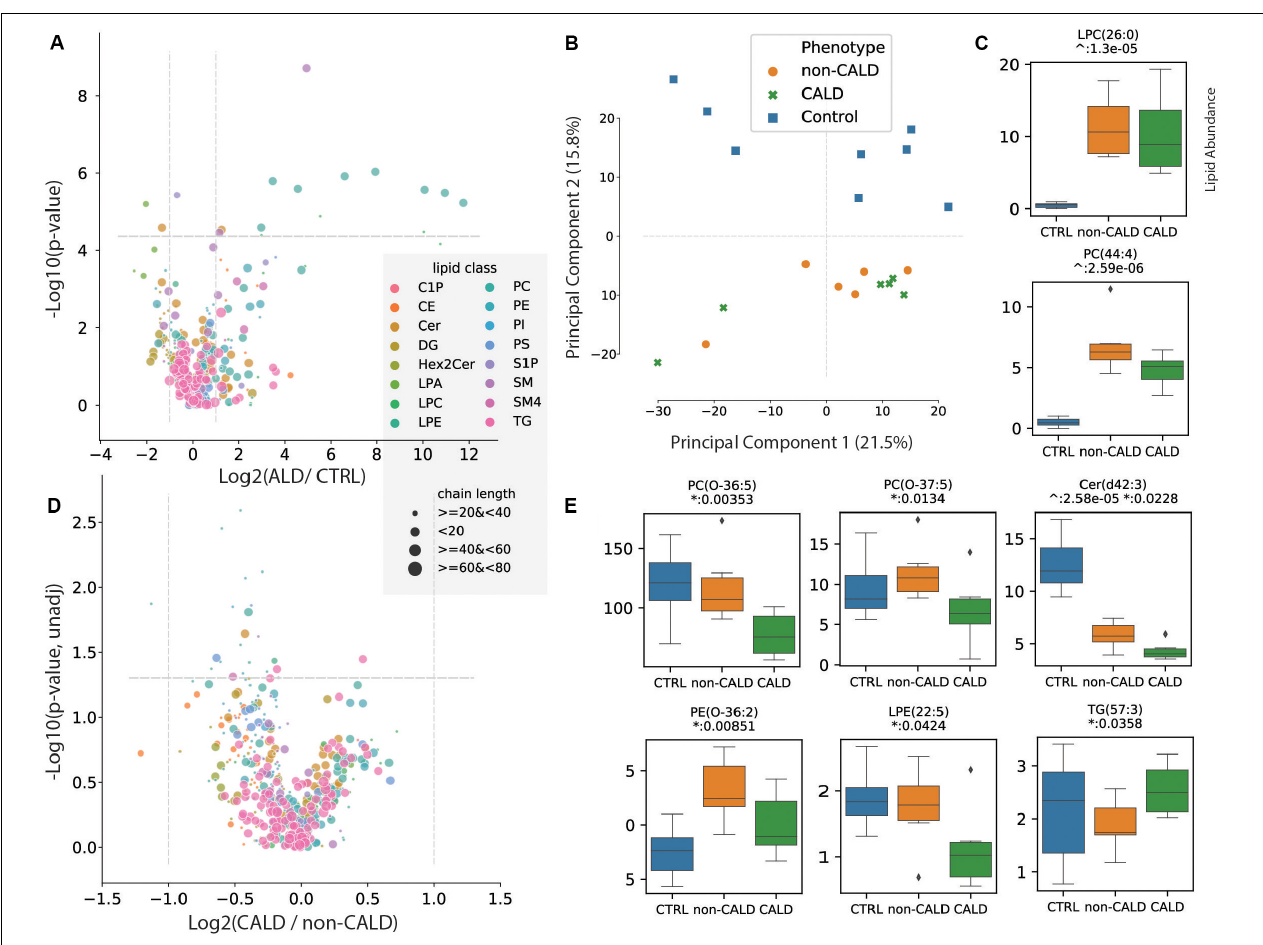
FIGURE 2 | Lipidomic analysis of ALD. The univariate analysis comparing the lipid abundances between control vs. ALD, and CALD vs. non-CALD is depicted. (A) Volcano plot showing the log2 fold change between ALD and control (CRTL) samples for all of the measured metabolites within the LCMS assay, versus the -log10 transformed adjusted p -value. (B) Principal component analysis plot showing the first two principal components which can discriminate between control (blue) and ALD (orange: non-CALD, green: CALD) samples. (C) Boxplots showing the abundances of a known marker for ALD, LPC(26:0), and another lipid differentially abundant between ALD and control samples. Values are lipid abundances measured on LCMS. (D) Volcano plot showing the log2 fold change between CALD and non-CALD samples versus the -log10 transformed p -value. (E) Boxplots for lipids different between CALD and non-CALD before p -value correction. For (A,D) , the lipids are colored according to their assigned class and their size corresponds to the lipid chain length. For boxplots: ∧ represents unadjusted p -values of comparison between ALD and control, * represents unadjusted p -values of comparison between CALD and